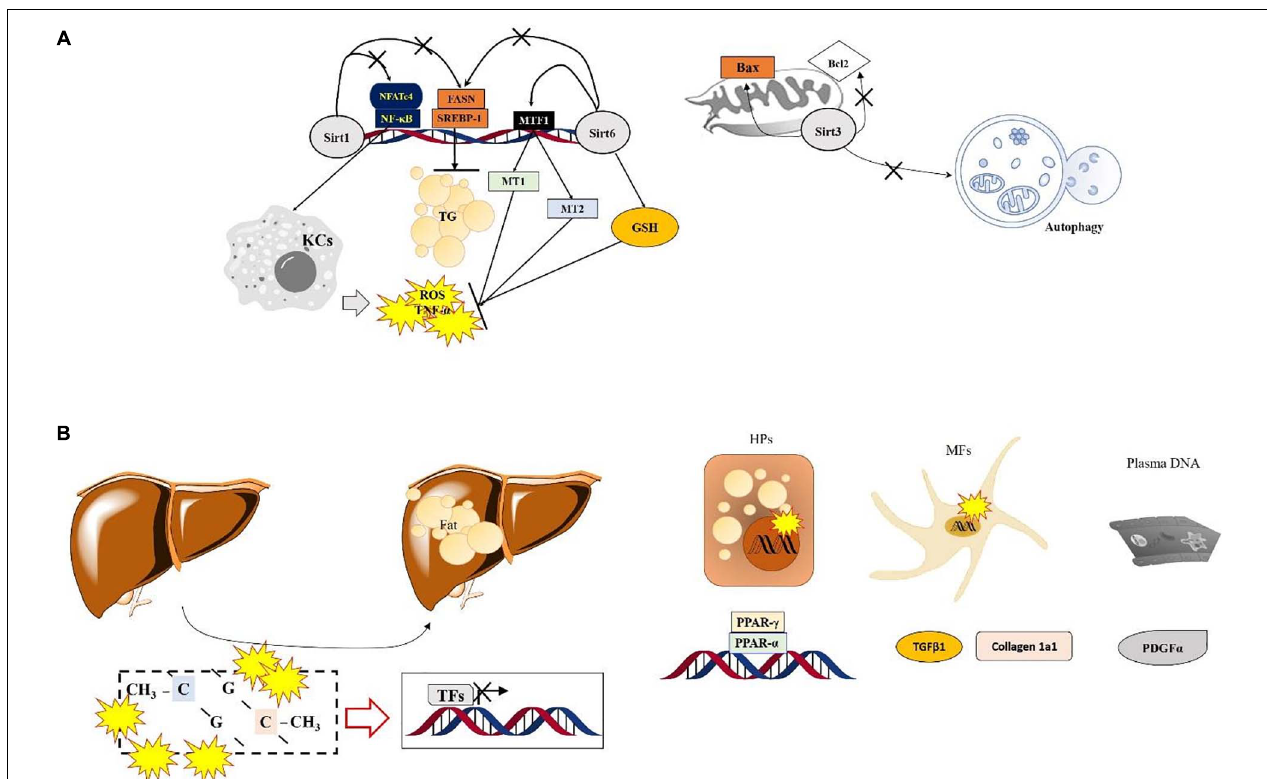
FIGURE 1 | Specific roles of Sirtuins and DNA methylation in ASH. (A) Numerous SIRT-modulated mechanisms mainly regulate hepatic inflammation via inactivation of Kupffer cells and reduce lipogenesis during ASH. Sirt6 shows protective effects by normalizing the ethanol metabolism and increasing antioxidant components via enhancement of MTF1 acylation in the nucleus. Sirt3 enhances the mitochondrial apoptotic signals and prevents autophagy. (B) The role of DNA methylation in ASH. Lipid-droplet accumulation in the liver during ASH is suppressed by regulating factors associated with the lipid homeostasis or extracellular matrix via the Ufmylation pathways in hepatocytes and myofibroblasts. In plasma DNA, DNA methylation also regulates PDGF α expression during